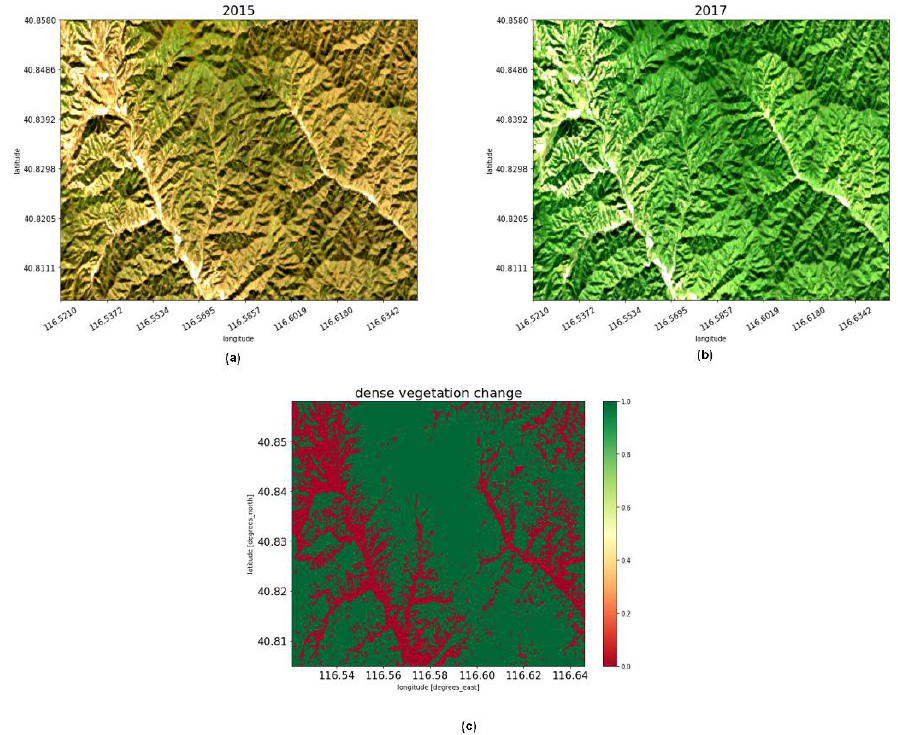
Figure 10. Result of the NDVI grass change detection between 2015 and 2017. ( a ) Partially enlarged RGB imagery view of the selected area in 2015, ( b ) partially enlarged RGB imagery view of the selected area in 2017, and ( c ) NDVI change of the selected area.